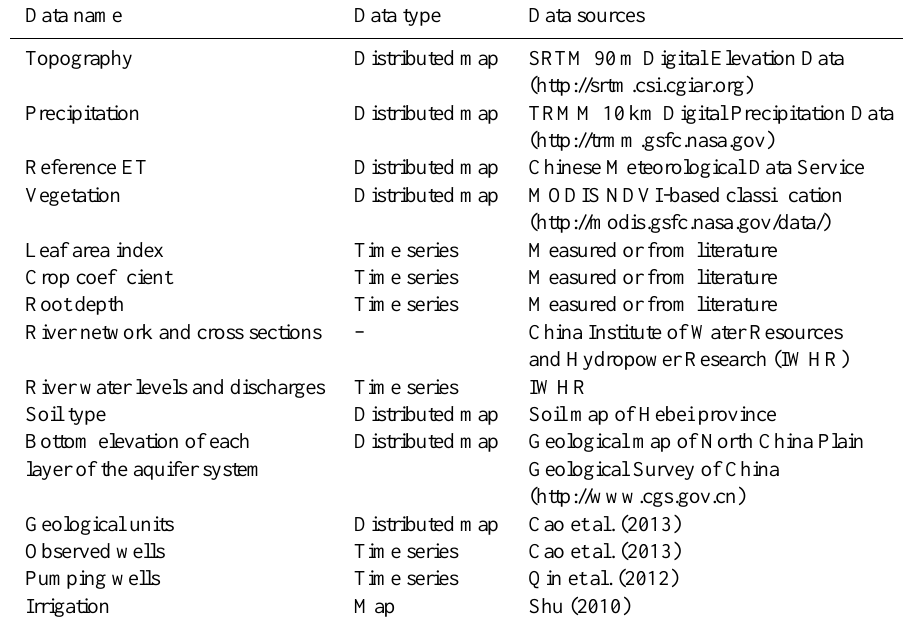
Table 1. Sources of the data used in the coupled MIKE SHE/MIKE 11 hydrological model of the NCP (Shu,